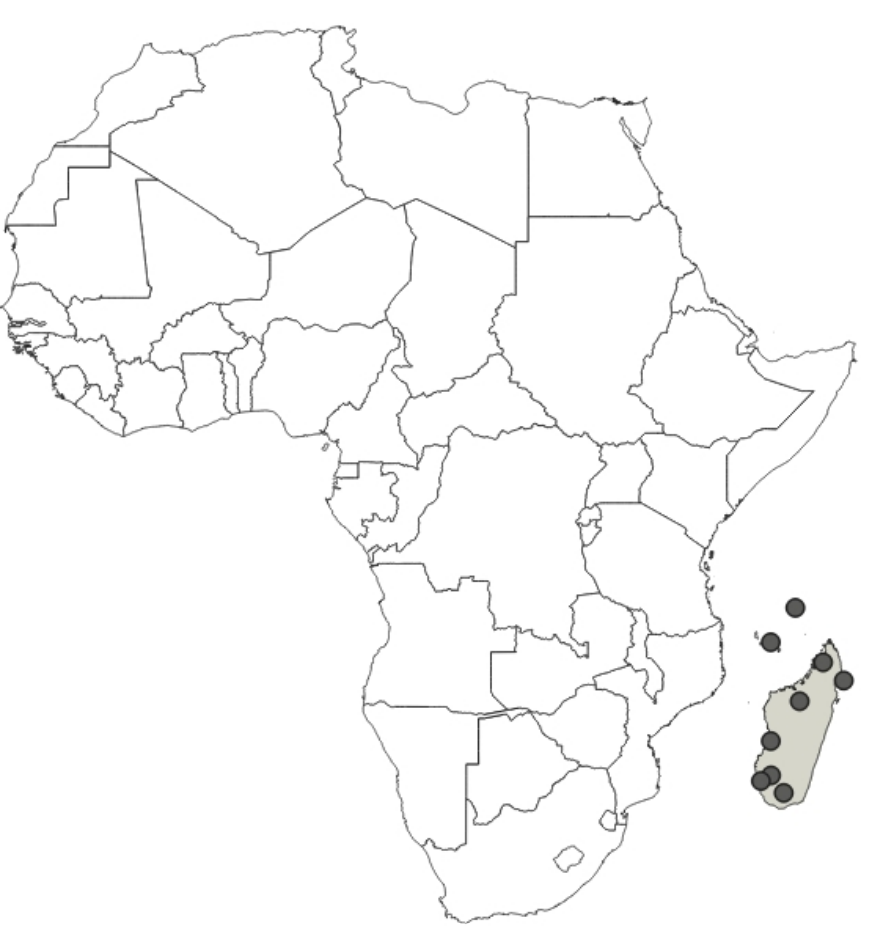
Figure 43. Known distribution of Phonoctonus grandis Signoret, 1860.